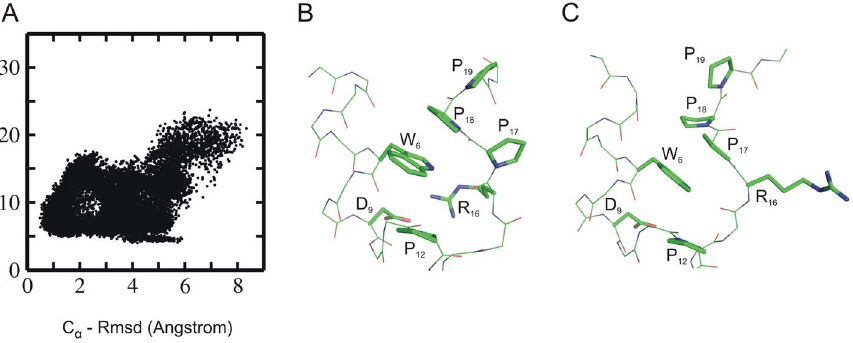
Figure 10. Rmsd and salt bridge distribution. (A) Distribution plot showing the correlation between RMSD C a (from native structure) and the salt-bridge distance between residues Asp9– Arg16 of sampled Trp-cage conformations (starting from intermediate states simulated using Amber 03 force field). (B) Example snapshot with a small near native salt bridge distance (side chains of residues near Trp6 are shown as sticks with labels, backbone as thin sticks). In this conformation the Pro18 stacks on the side chain of Trp6. (C) Example of a near-native sampled state with large Asp9- Arg16 distance and non-native stacking of Pro17 (instead of Pro18) onto the Trp6 side chain.